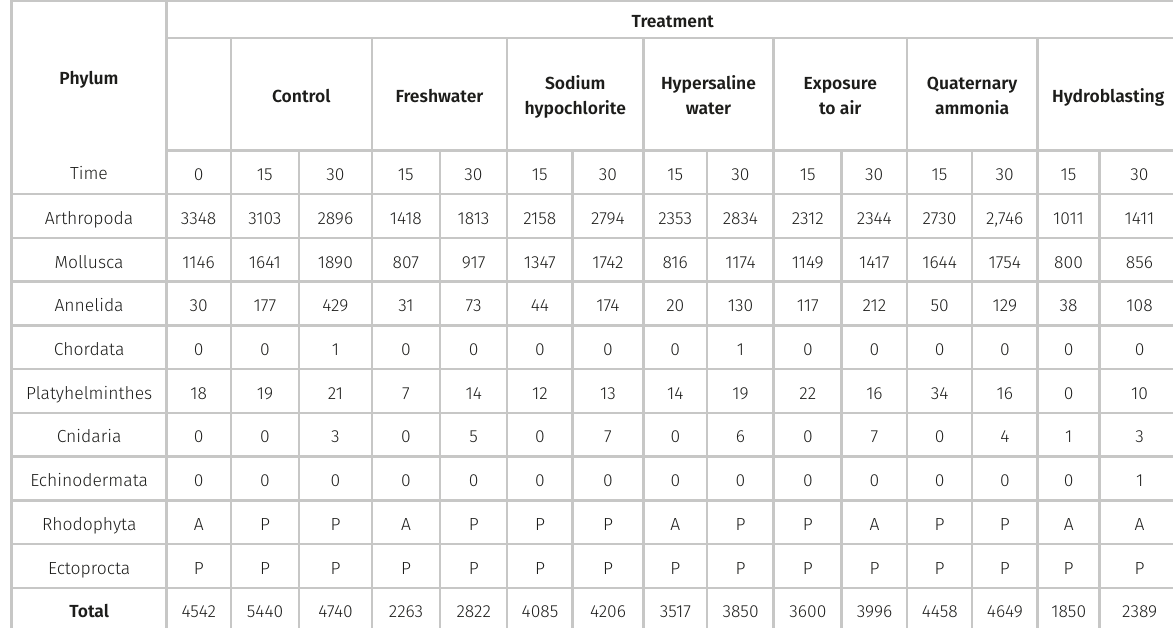
Table IV. Number of epibionts on the oyster shells submitted to different cleaning treatments after 0, 15 and 30